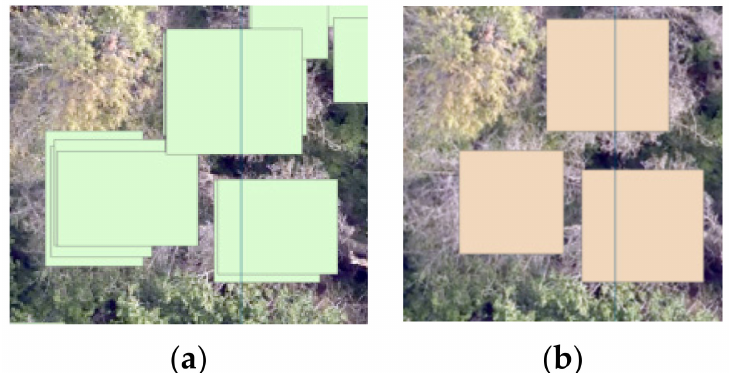
Figure 6. NMS optimization effect comparison chart. ( a ) Before NMS ( b ) After